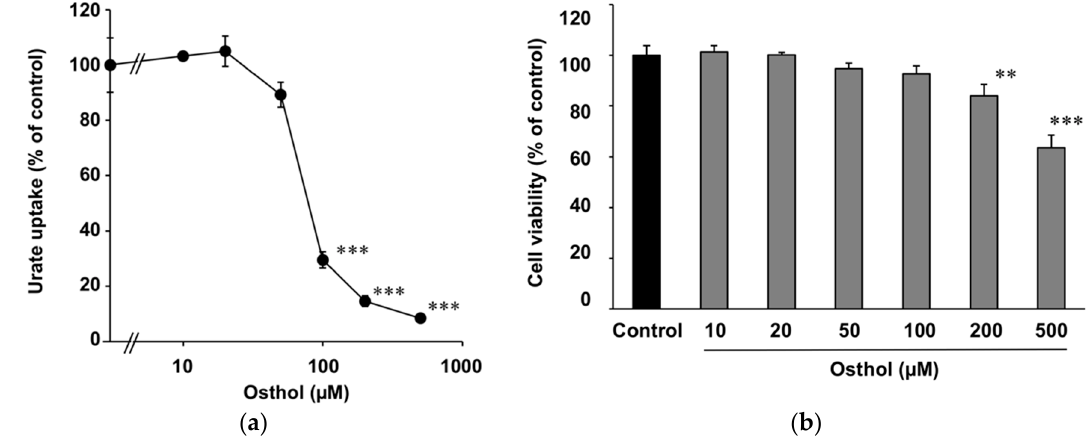
Figure 4. Effect of osthol on the uptake of uric acid via URAT1. ( a ) HEK293/PDZK1 cells were transiently transfected with human URAT1. Cells were incubated with uric acid (11.6 µM) with or without osthol at 37 °C for 30 min, and the uptakes of uric acid into the cells were measured. Data are expressed as the mean ± S.E. ( n = 3). ( b ) Cytotoxicity of osthol was measured using the MTT method. Data are expressed as the mean ± S.E. ( n = 6). ** p < 0.01 and *** p < 0.001 vs. the control group by ANOVA and Bonferroni–Dunnett’s multiple t -test.